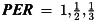
PSNR and SSIM plots in each energy channel when PER = 1,12,13 respectively with Poisson noise added to the ideal projection data.